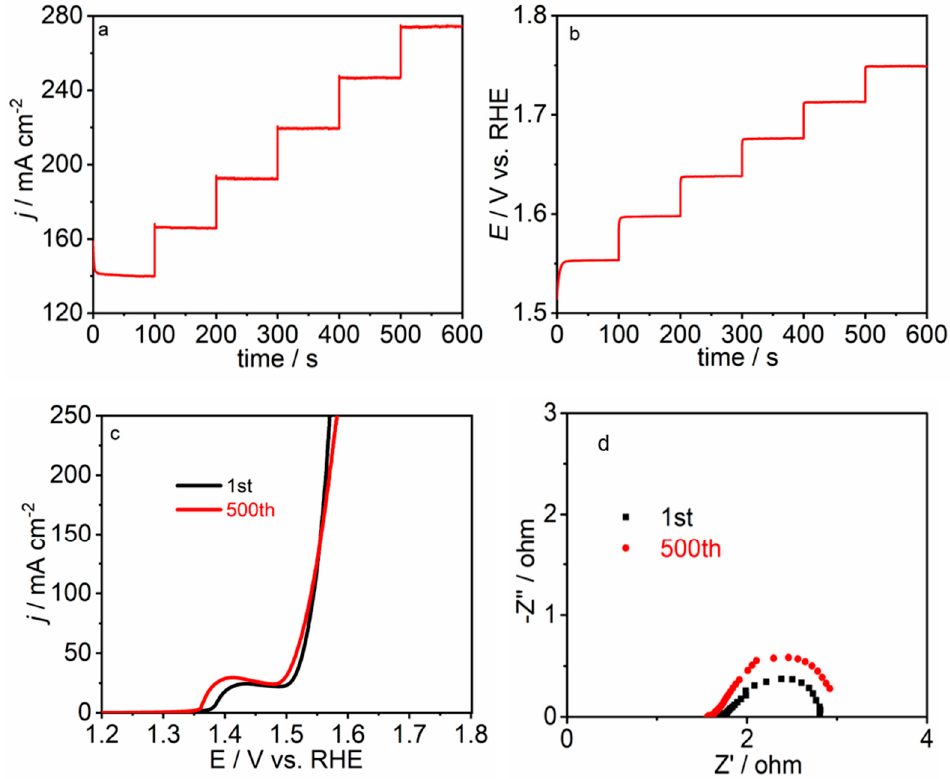
Figure 6. ( a ) The multi-potential steps ( b ) the multi-current steps ( c ) the polarization curves of the Ni(OH) 2 /MoS 2 /NF electrode before and after 500 cycles cyclic voltammetry ( d ) electrochemical impedance spectra of Ni(OH) 2 /MoS 2 /NF electrode before and after 500 cycles of cyclic voltammetry.